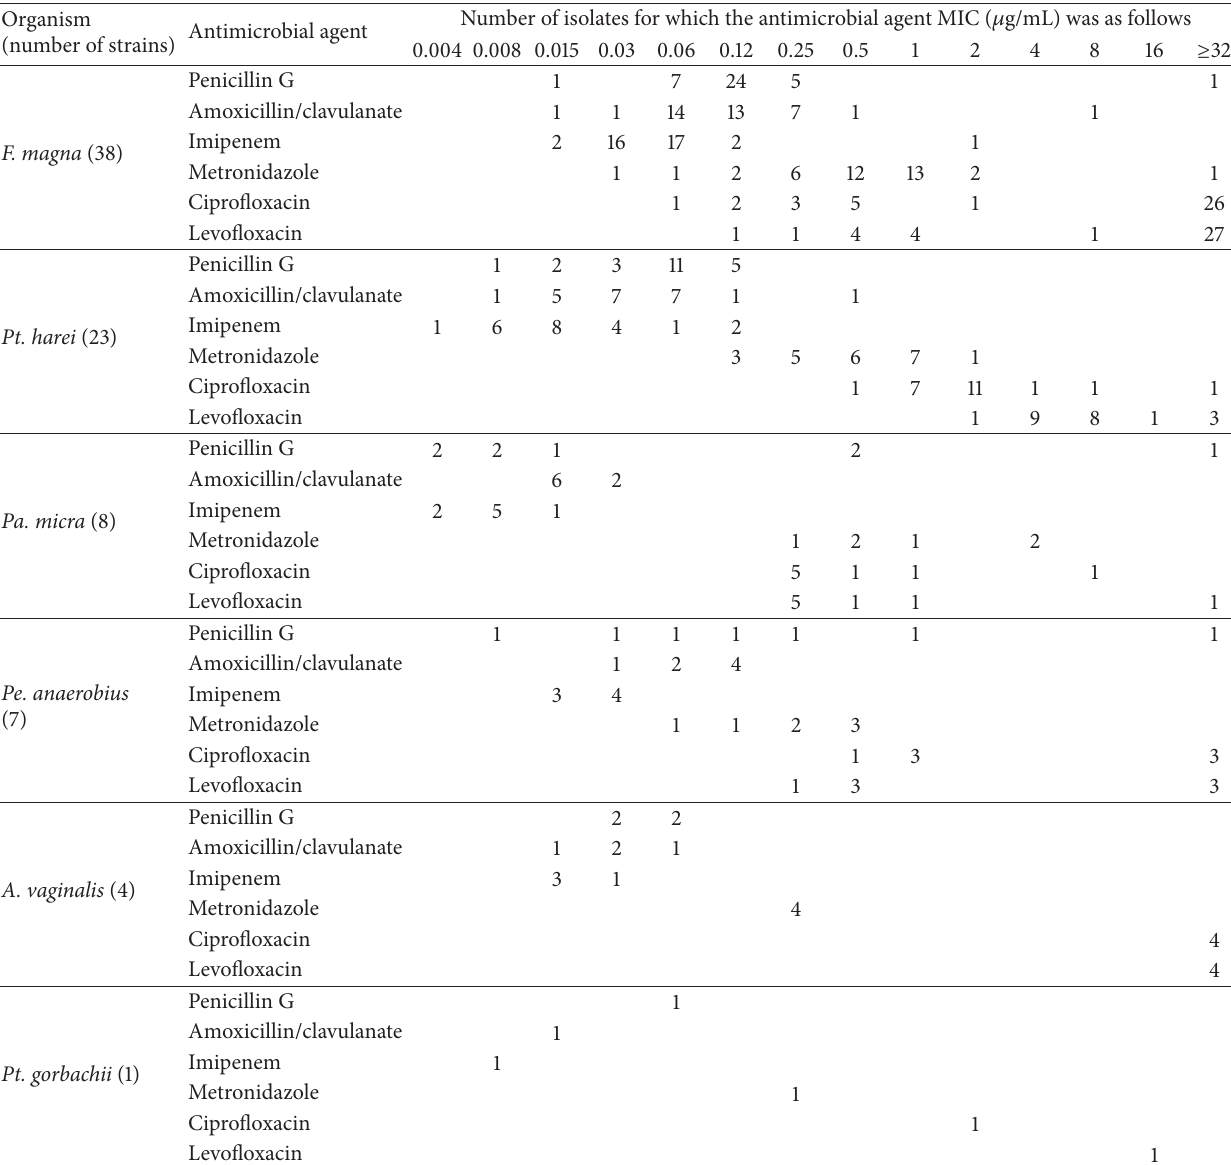
Table 2: MIC distribution of antimicrobial agents tested against GPAC isolates. Number of isolates for which the antimicrobial agent MIC ( 𝜇 g/mL) was as Organism Antimicrobial agent (number of strains)